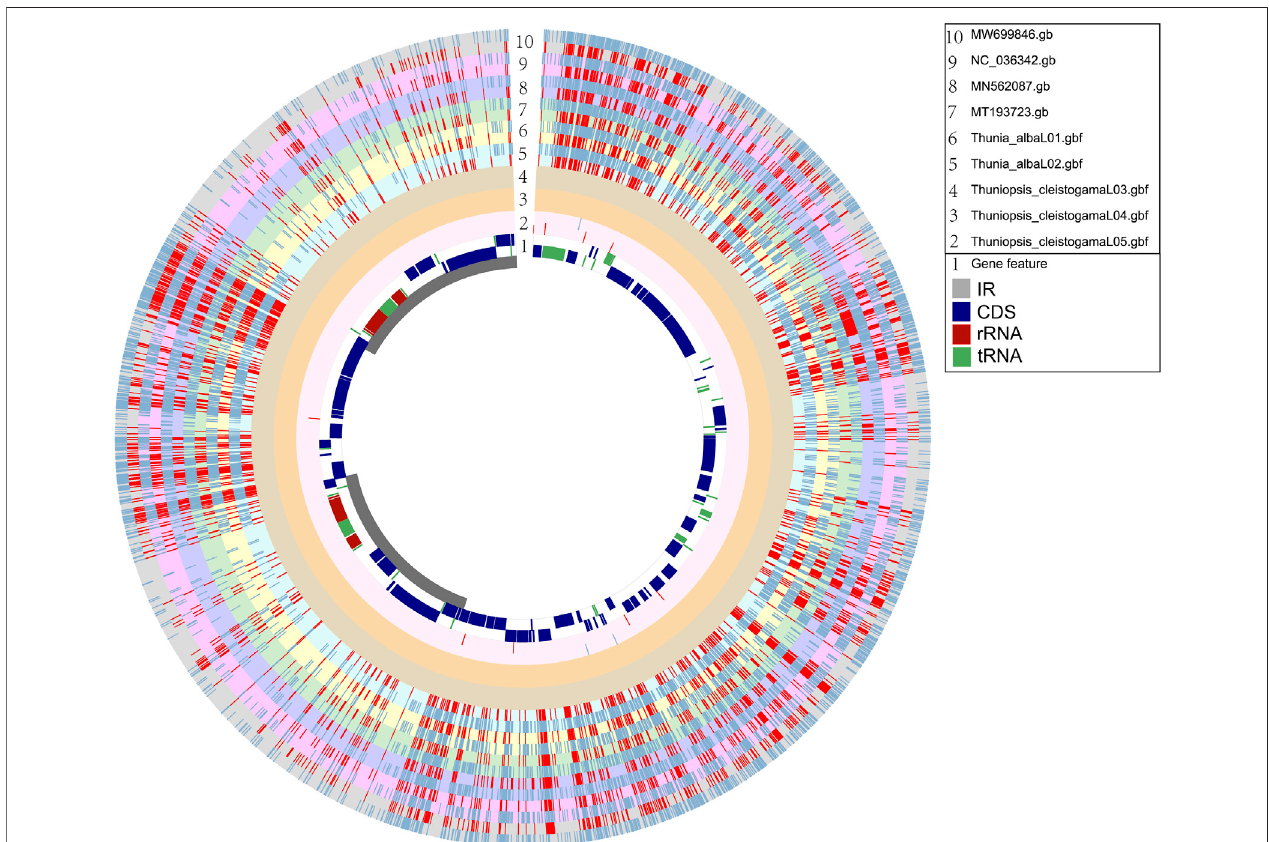
FIGURE5 | Circos plot based on complete plastome alignmentofnewly sequenced plastomes( Thuniopsiscleistogama and Thunia alba ) and relativesavailable at NCBI (MN562087, MT193723, MW699846 and NC_036342). Ring “ 1 ” shows the reference plastome alignment of Thuniopsis cleistogama_ L04, with coding genes labeled in dark blue, rRNAs in red and tRNAs in green. Inner ring, gray: IR region, white: LSC and SSC regions. The rings “ 2 – 10 ” indicate SNPs and InDels, respectively. Blue shadows denote the locations of SNPs; Red shadows denote the locations of InDels. The height of columns in rings “ 2 – 10 ” represents the relative number of polymorphic loci. From outside to inside, ring “ 10 ” shows MW699846 (gray); ring “ 9 ” shows NC_036342 (pink); ring “ 8 ” shows MN562087 (blue); ring “ 7 ” shows MT193723 (light green); ring “ 6 ” shows Thunia alba_ 01 (light yellow); ring “ 5 ” shows Thunia alba_ 02 (light blue). ring “ 4 ” shows Thuniopsis cleistogama _03 (dusty gray); ring “ 3 ” shows Thuniopsis cleistogama 04 (ochre); ring “ 2 ” shows Thuniopsis cleistogama _05 (light pink). Two contiguous rings with same color indicate positive and negative strand,